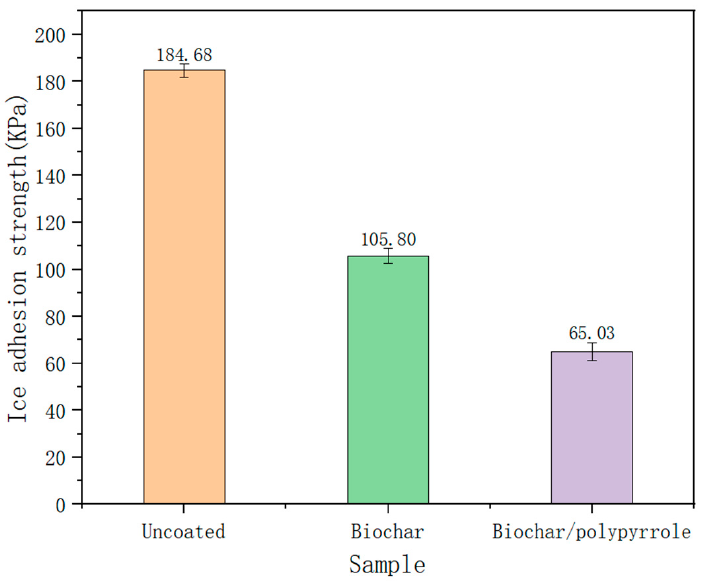
Figure 5. Blade icing bond strength of uncoated coating, biochar coating, and biochar/polypyrrole coating.